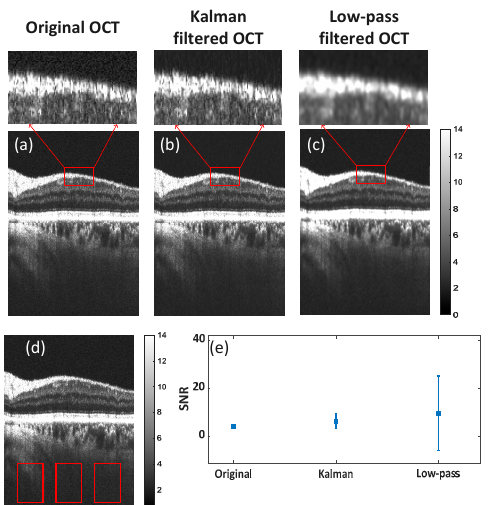
Figure 8. Comparison between using the Kalman filter and using the low-pass filter in in vivo experiments. ( a – c ) The original OCT images, the Kalman-filtered OCT images and the low-pass-filtered OCT images, respectively. The upper subimages are locally magnified images from ( a – c ), respectively. Three regions extracted from the deep positions of ( a – c ) are shown in ( d ). ( e ) The mean and standard deviation of the SNR of the three regions.